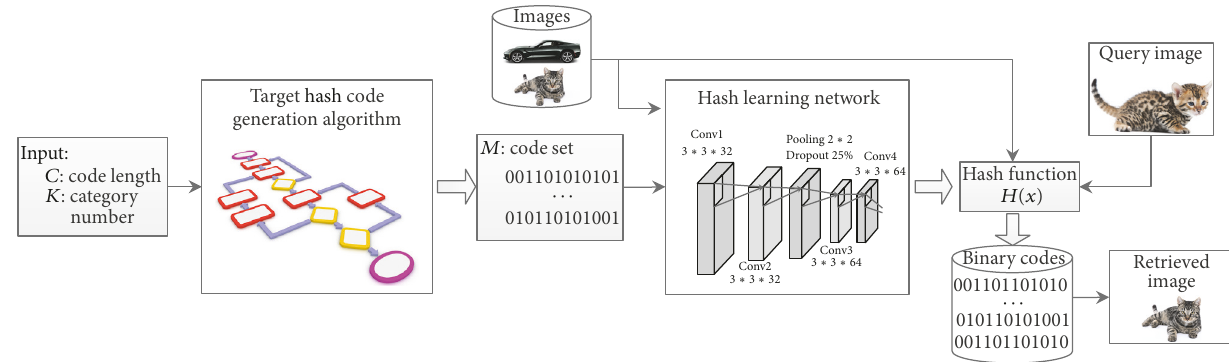
Figure 1: The process flow of our work. First, we use our proposed target hash code generation algorithm to generate optimal hash code set. Next, we use hash code set and training images to train the hash learning CNN network, which is regarded as the hash function. Finally, we use the hash function to perform content-based image retrieval.